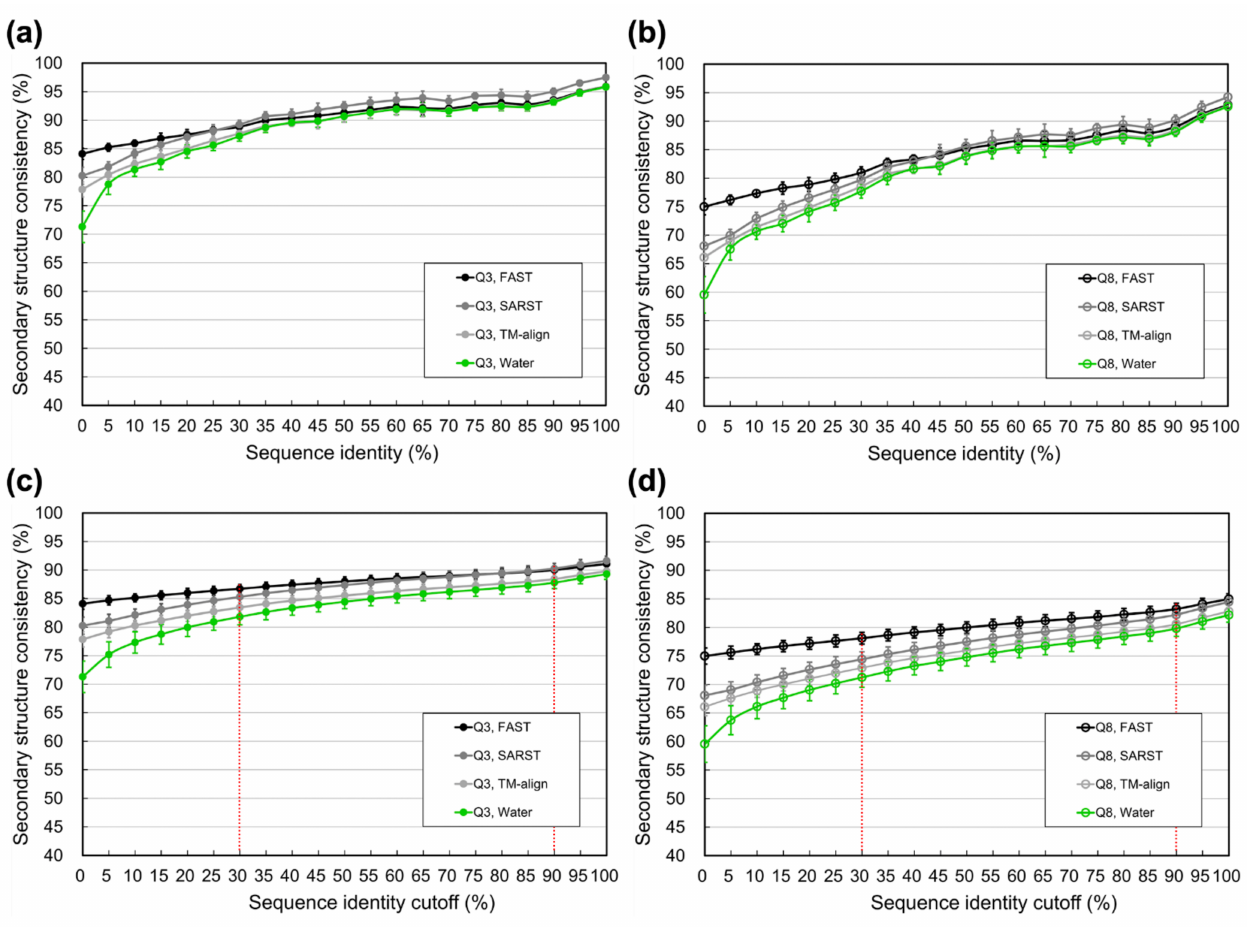
Figure 3. Secondary structural consistency measured by structural alignments between structural homologs